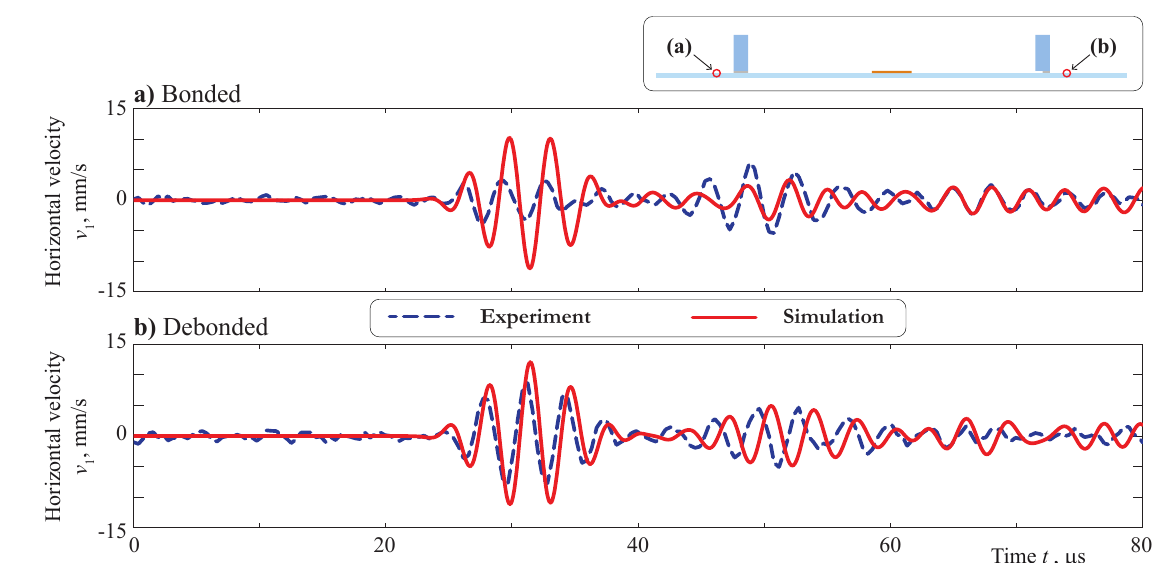
Figure 6. Horizontal velocities at the surface of the plate for bonded ( a ) and debonded ( b ) obstacles measured and calculated at the central frequency f = 300 kHz at the points x 1 = ± 130 mm.